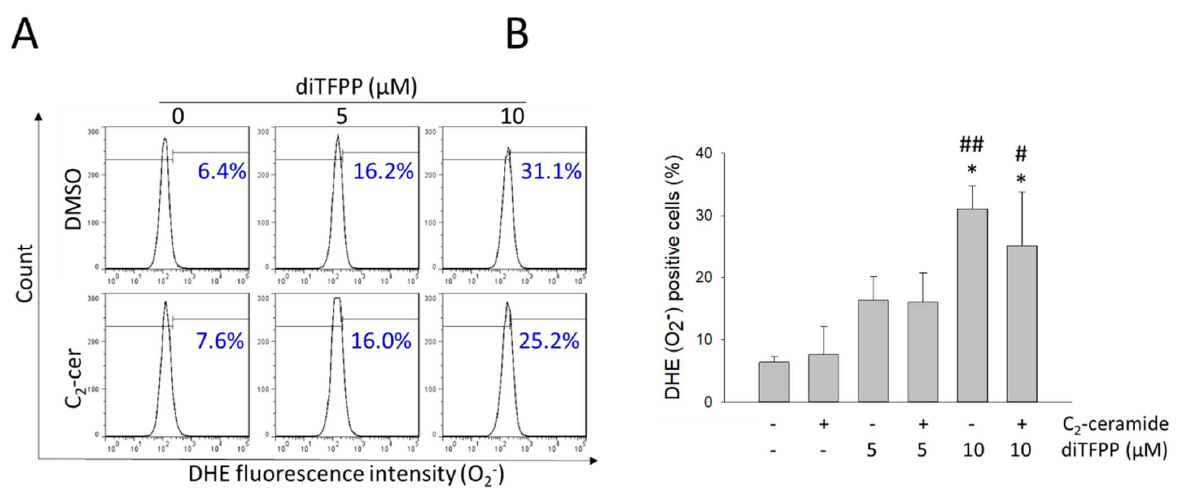
Figure 2. Effect of diTFPP on C 2 -ceramide-induced endogenous ROS production in HCC cells. ( A ) Endogenous ROS were evaluated in cells treated with 20 μM C 2 -ceramide alone and in combination with diTFPP for 24 h using a DHE fluorescence-based flow cytometric assay. ( B ) Quantitative anal- ysis of the data in ( A ). # p < 0.05 and ## p < 0.01; the control group compared with the indicated treatment groups. * p < 0.05; the group treated with C 2 -ceramide alone compared with the indicated treatment groups. All data are presented as the mean ± SD of three independent assays.